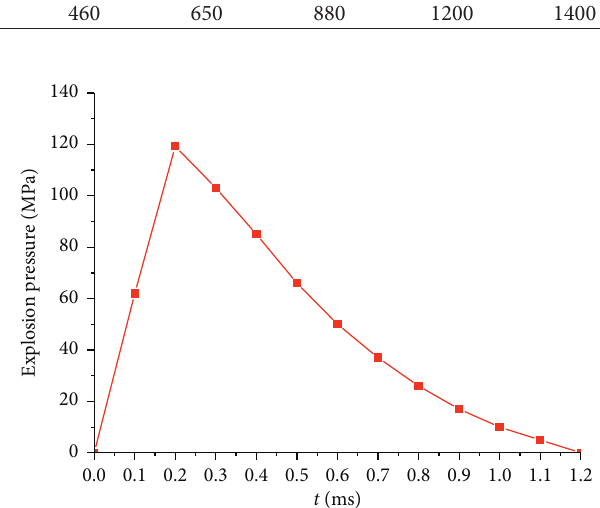
Figure 4: Equivalent triangle explosion pressure of the under- ground powerhouse (unit: